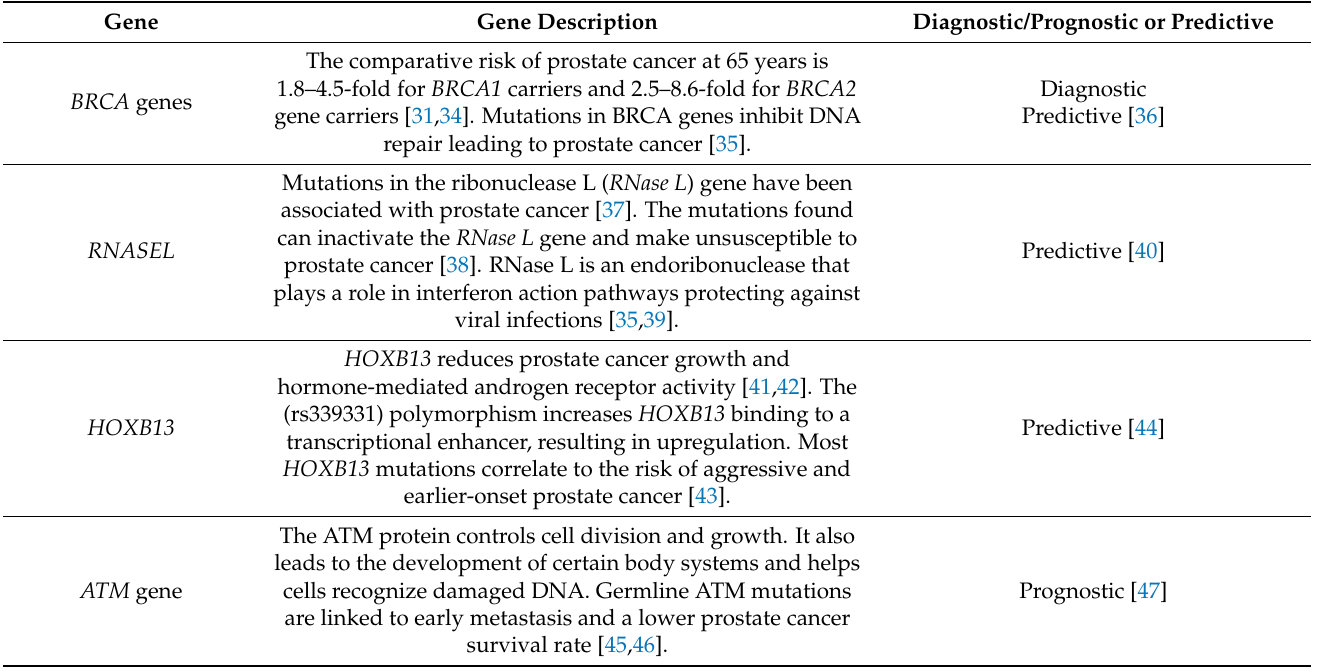
Table 2. Prostate cancer genes used as biomarkers for the